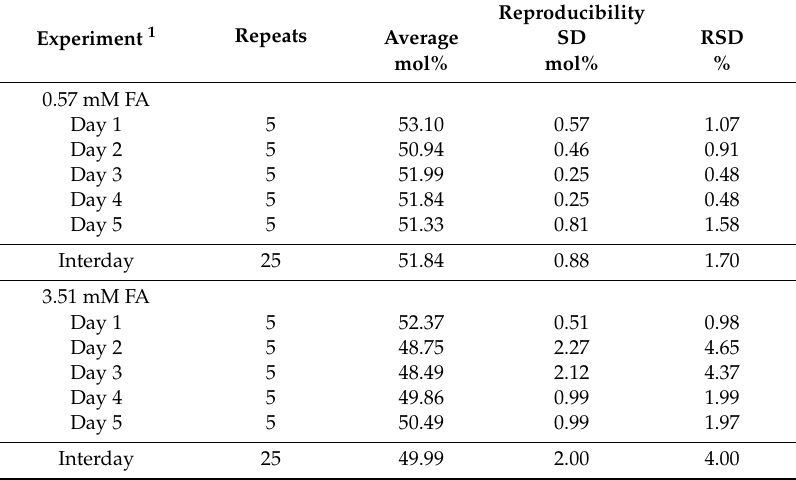
Table 2. Intraday and interday